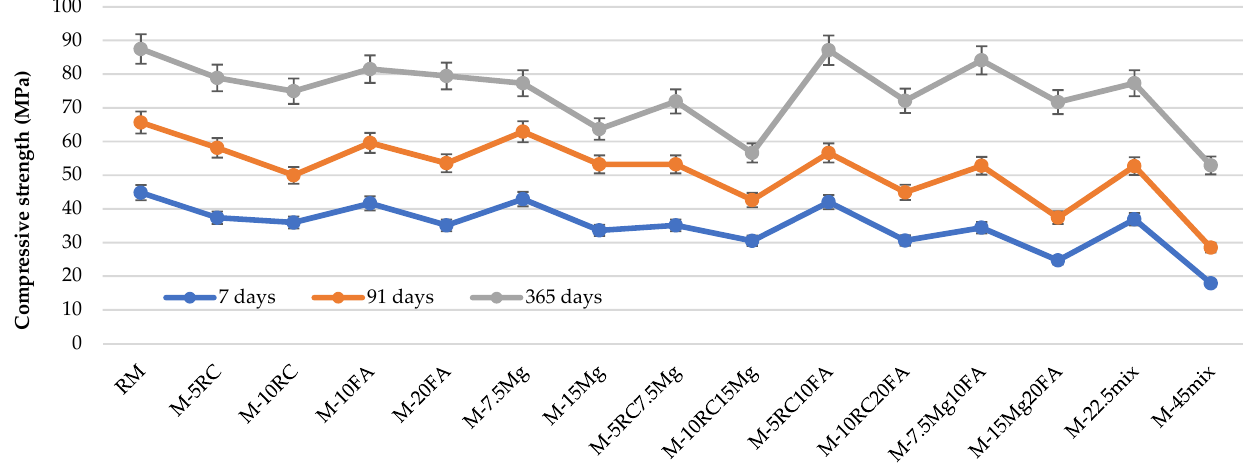
Figure 2 . Compressive strength at 7, 91, and 365 days. Figure 2. Compressive strength at 7, 91, and 365 days.